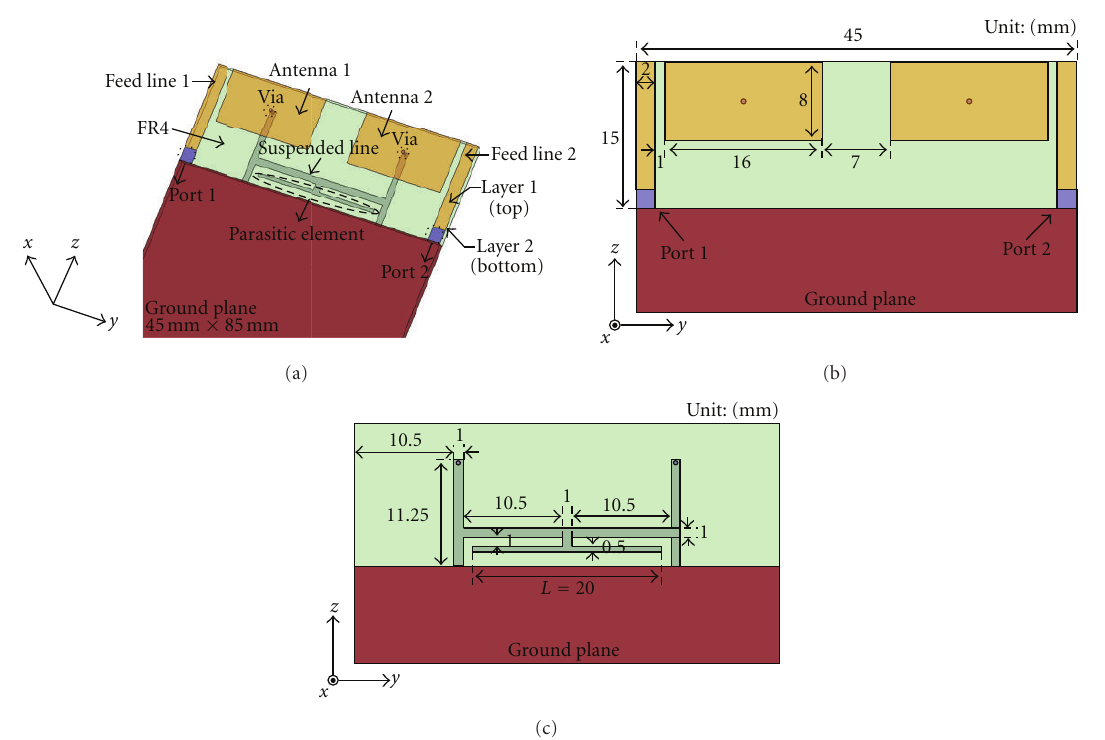
Figure 1: Geometry of the proposed antenna: (a) overall view, (b) detailed view of layer 1 (top), and (c) detailed view of layer 2 (bottom).